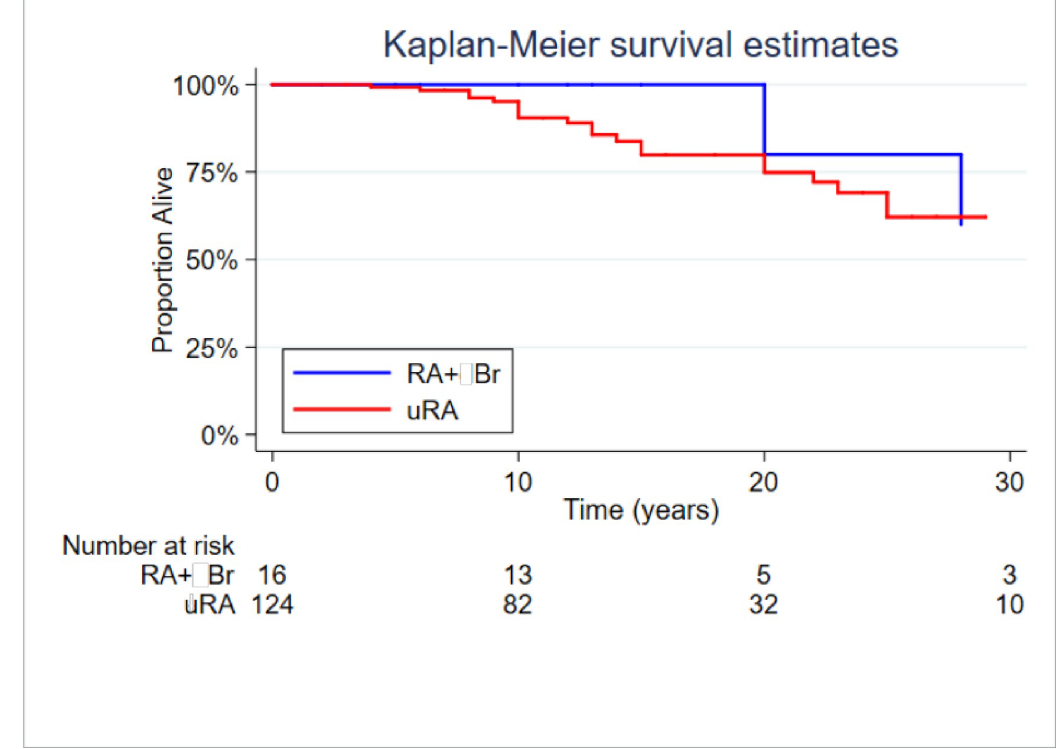
Fig 2. Kaplan-Meier survival estimates for coexistent RA+Br versus RA without bronchiectasis.